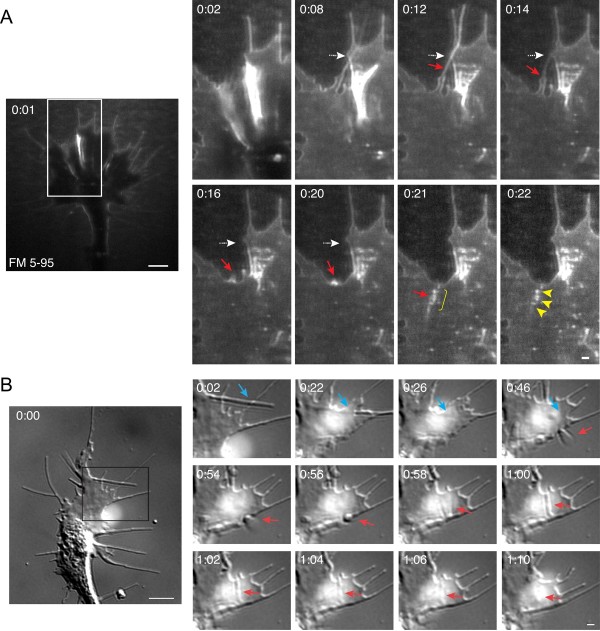
Small vesicle endocytic hot-spots triggered by filopodial - lamellipodial contacts. (A) Time-lapse confocal images of FM 5-95 internalization show a detached filopodium collapse atop the dorsal surface of the growth cone and trigger an endocytic hot-spot. The boxed region is magnified in the right panels and the time after the initial membrane labeling (minutes:seconds) is indicated in each frame. The dashed arrows (white) are static and indicate the initial position of the filopodium. The detached filopodium lifts out of the focal plane (0:15 to 0:20, red arrows) and within seconds collapses atop the growth cone body (yellow bracket, 0:21), eliciting a streak of small vesicles (yellow arrowheads, 0:22). See Additional file 4 for the corresponding time-lapse movie. (B) Time-lapse DIC images show a similar loss of filopodia atop the dorsal surface of the growth cone. Detached filopodia (blue and red arrows) approach lamellipodia and rapidly disappear. One filopodium (red arrow) lifts out of the focal plane (0:46 to 56), collapses atop a lamellipodium (0:58 to 1:06), and disappears as in (A). The corresponding time-lapse movie is shown in Additional file 5. Scale bars, 5 μm (left), 1 μm (right).